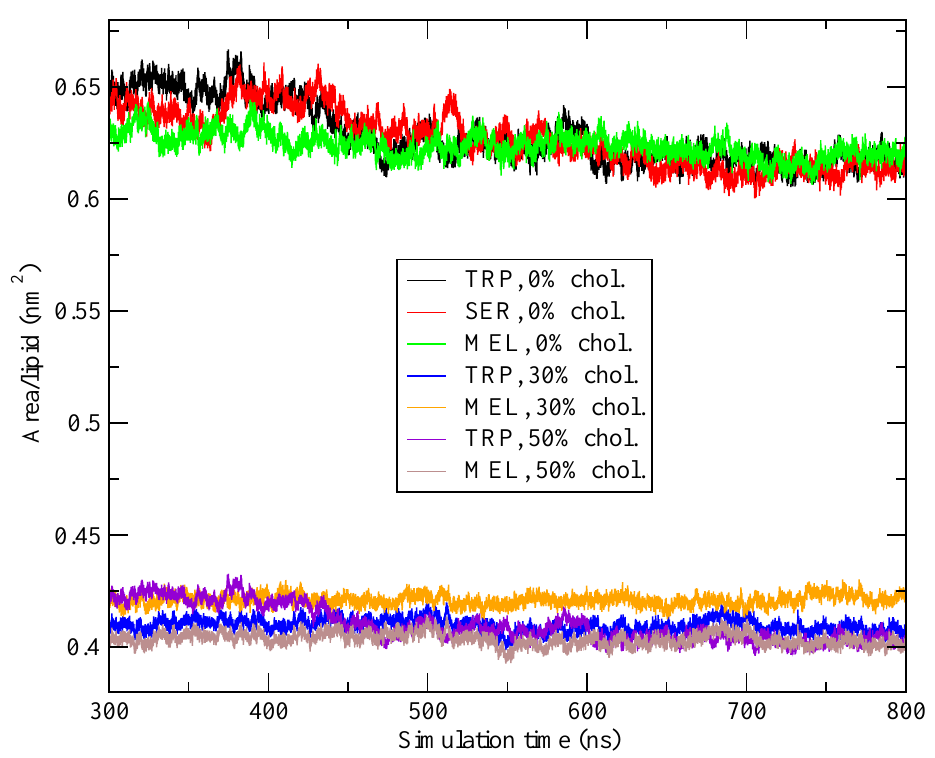
Figure 2. Area per lipid of systems with different cholesterol contents: 0%, 30%, and 50% as a function of simulation